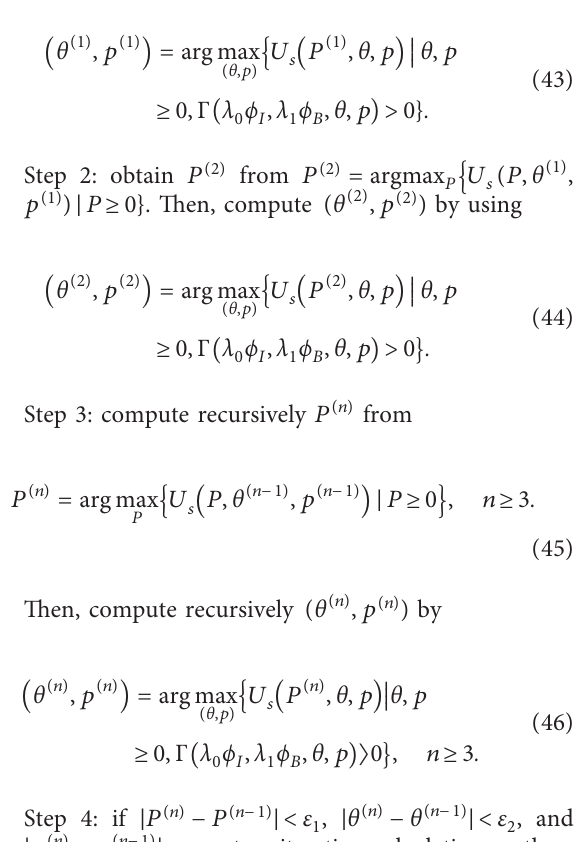
Figure 6: P ∗ , θ ∗ ,p ∗ vs. the number of iterations for R � 5 , C � 0 . 3 ,C � 0 . 1 , λ � 0 . 5 , λ � 0 . 6 , β � 0 . 8 , β � 0 . 4 , c � 0 . 5 , 0 . 2 , C 1 2 0 1 1 2 and δ � 0 .